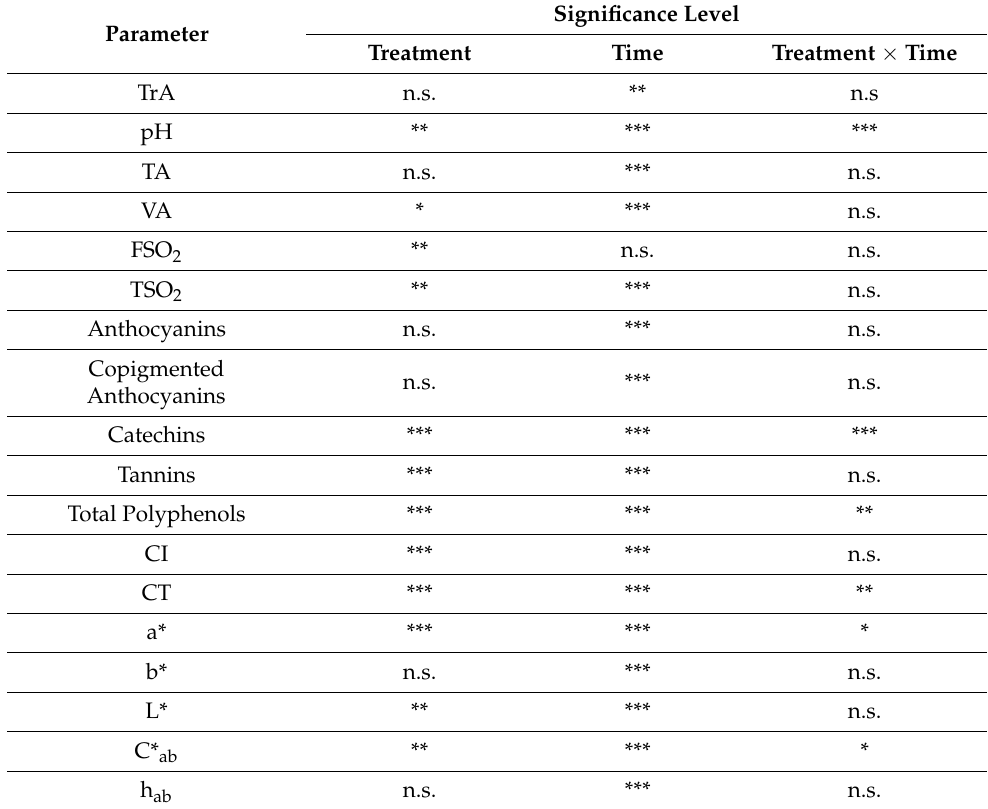
Table 3. Effect of the application of HHP and maceration with holm oak chips (Treatments), Sampling date (Time), and their interactions on values of chemical parameters in Tempranillo wine. Significance Level Parameter Treatment Time Treatment × Time TrA n.s. ** n.s pH ** *** *** TA n.s. *** n.s. VA * *** n.s. FSO 2 ** n.s. n.s. TSO 2 ** *** n.s. Anthocyanins n.s. *** n.s. Copigmented n.s. *** n.s. Anthocyanins Catechins *** *** *** Tannins *** *** n.s. Total Polyphenols *** *** ** CI *** *** n.s. CT *** *** ** a* *** *** b* n.s. *** n.s. L* ** *** n.s. C* ab ** *** * h ab n.s. ***